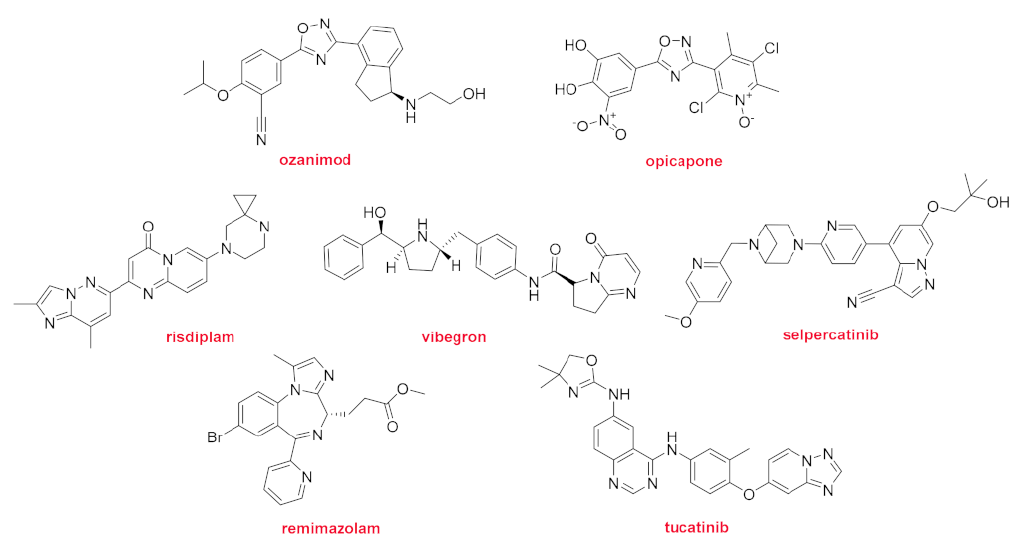
Figure 13. Structure of drugs containing nitrogen aromatic heterocycles.